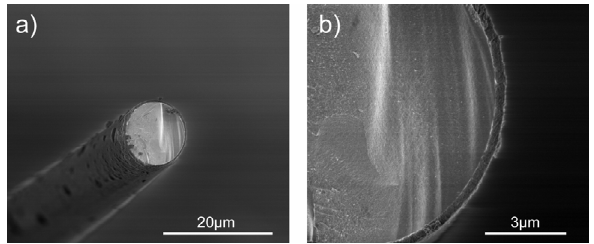
Fig. 2 SEM images of KD-S SiC fiber with BN interface layer.